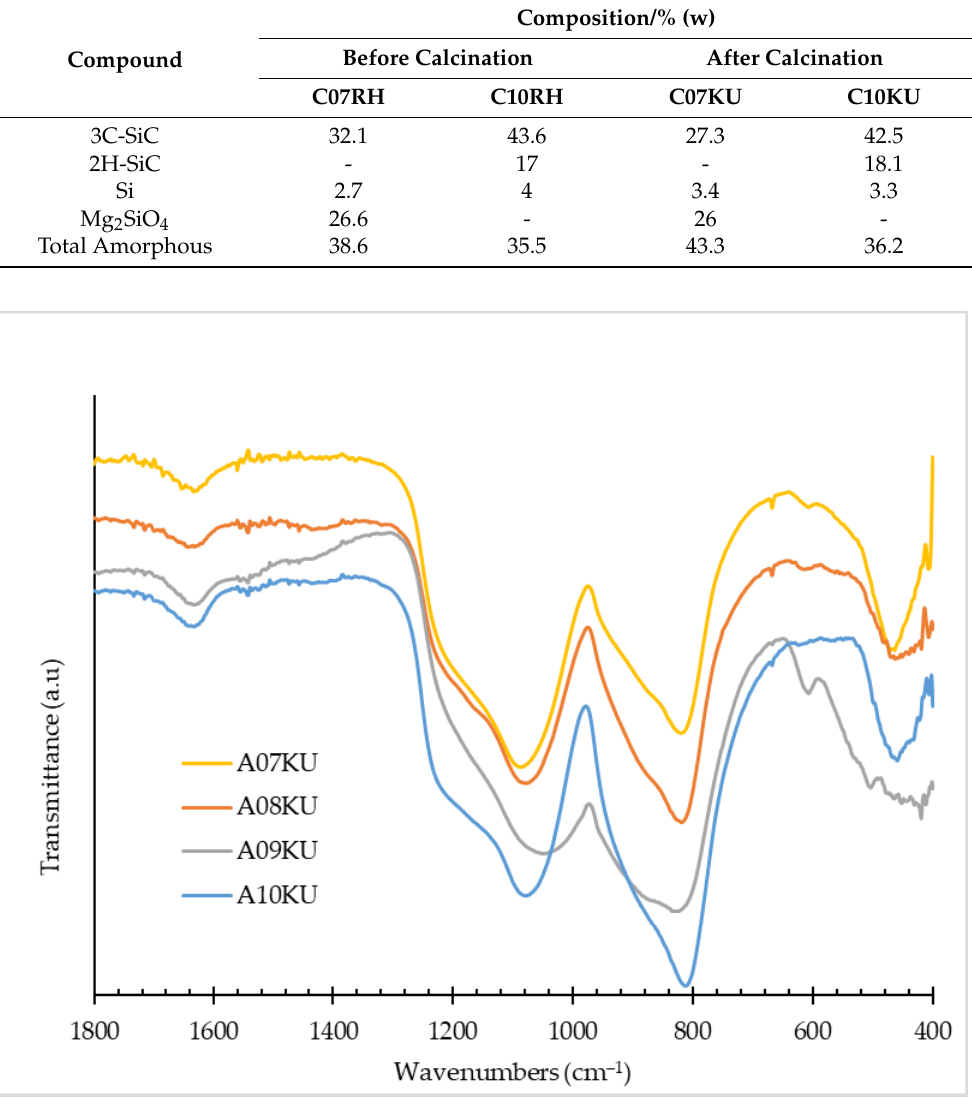
Table 5. Comparison of compound composition of HCl washing product and air calcined product.